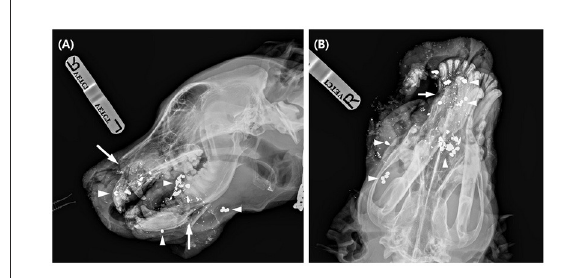
FIGURE1 Lateral (A) and dorsoventral (B) radiographs of the dog at presentation. On the lateral view, there are some radiolucent fracture lines (arrow) at the incisive bone, mandible, and multiple metal opacities (arrowhead) around the facial area. In the dorsoventral view, bone and soft tissue loss in the right rostral area was evident.